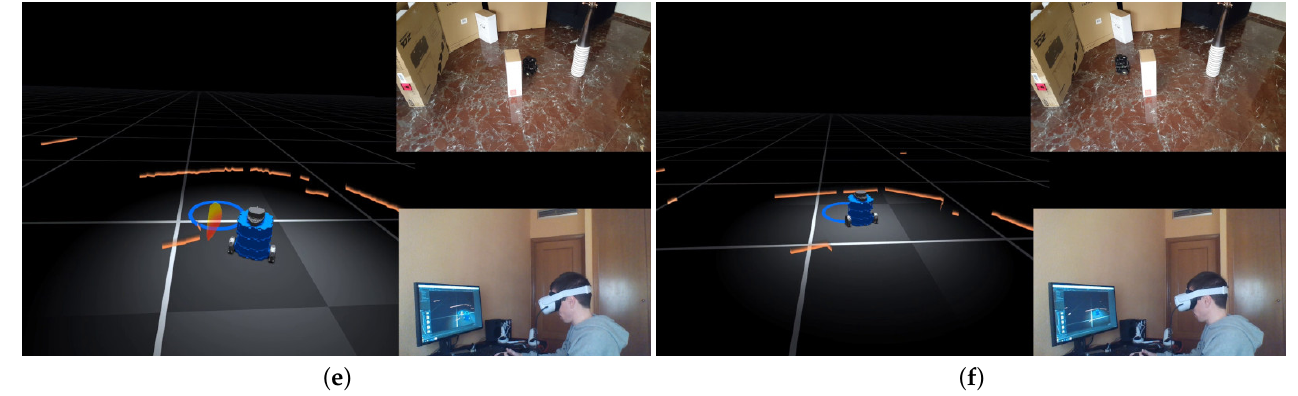
Figure 7. Case study 2: frames of the video showing obstacle avoidance situations. ( a ) video: 0 min 45 s. ( b ) video: 0 min 56 s. ( c ) video: 1 min 8 s. ( d ) video: 1 min 19 s. ( e ) video: 1 min 28 s. ( f ) video: